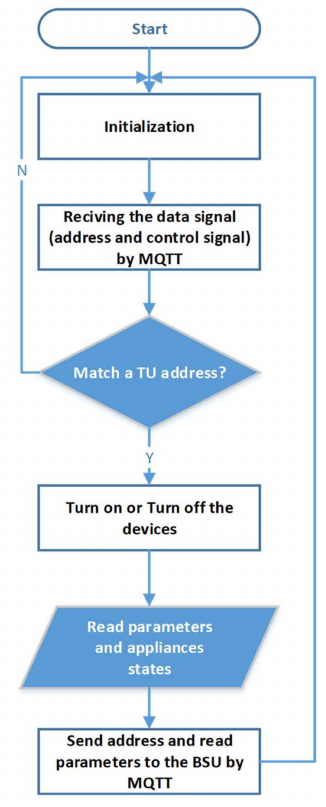
Figure 11. Terminal Unit flowchart.